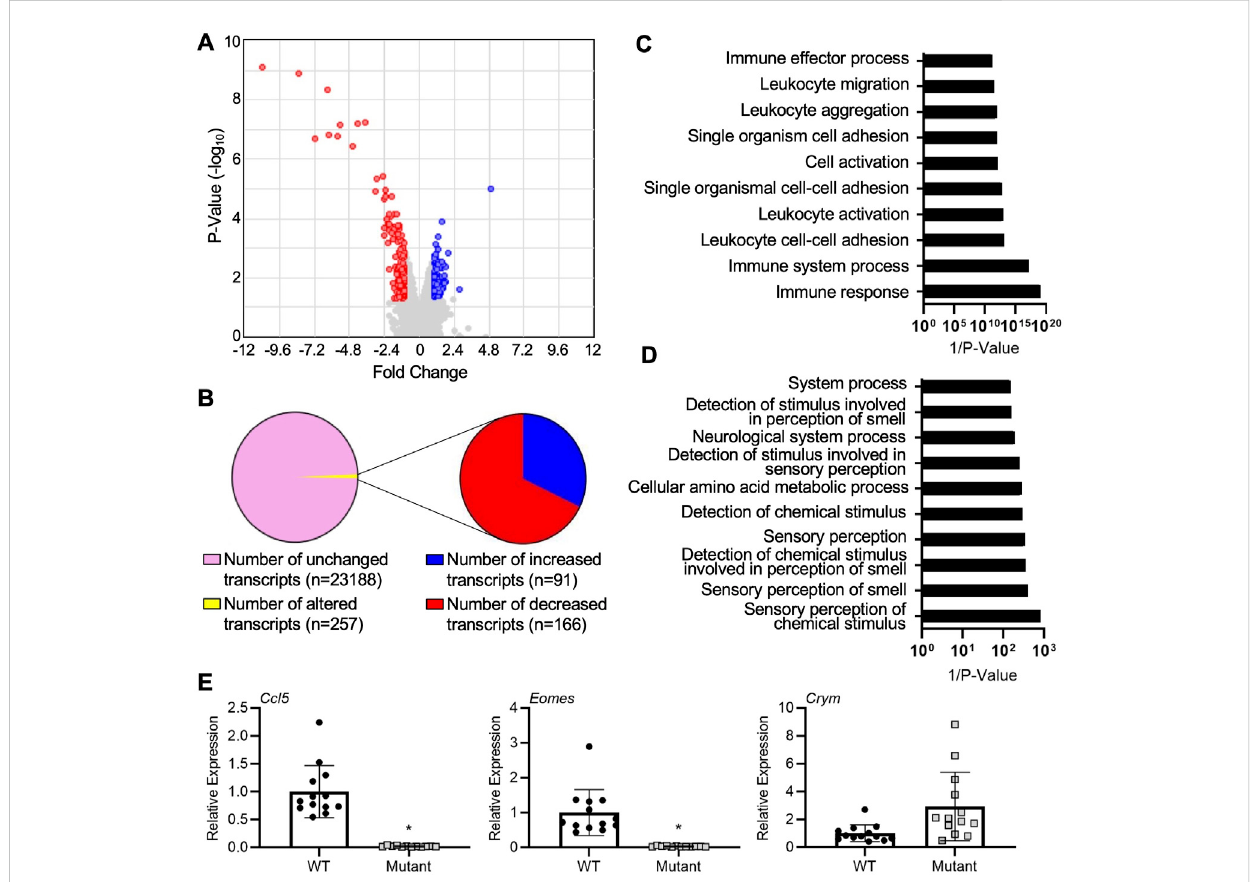
FIGURE 1 Geneexpressionpro fi lingofimplantationsitesfromWTand IL15 Δ / Δ rats. (A) Volcanoplotshowingthenumberofuniquetranscriptsidenti fi edinthe Clariom S analysis. Transcripts signi fi cantly (fold change > 2, p < 0.05) upregulated in implantation sites from IL15 Δ / Δ rats compared to WT rats are shown in blue, and downregulated transcripts are shown in red. The x -axis represents magnitude of fold change, and the y -axis shows p -value. (B) Pie chart showingthenumberoftranscriptsupregulatedanddownregulated(2-fold, p < 0.05)inimplantationsitesfrom IL15 Δ / Δ ratscomparedtoWTrats. (C) Top 10 gene ontology pathways downregulated in implantation sites from IL15 Δ / Δ rats. (D) Top 10 gene ontology pathways upregulated in implantation sitesfrom IL15 Δ / Δ rats.Pathwayanalysiswasconductedbyinputtingtranscriptschangedmorethan2-foldwitha p < 0.05in IL15 Δ / Δ ratscomparedtoWT ratsintoDAVIDBioinformaticsResource( N =3foreachgroup). (E) QuantitativeRT-PCRwasusedtocomparetherelativeexpressionofselecttranscripts in a separate cohort of GD 9.5 implantation sites from IL15 Δ / Δ rats (mutant) and WT rats. N ≥ 13 implantation sites from at least 5 dams per group. Results represent means ± SEM, and were analyzed using a linear mixed model followed by Tukey ’ s post hoc test. Data signi fi cantly different from controls ( p < 0.05) are indicated by an asterisk